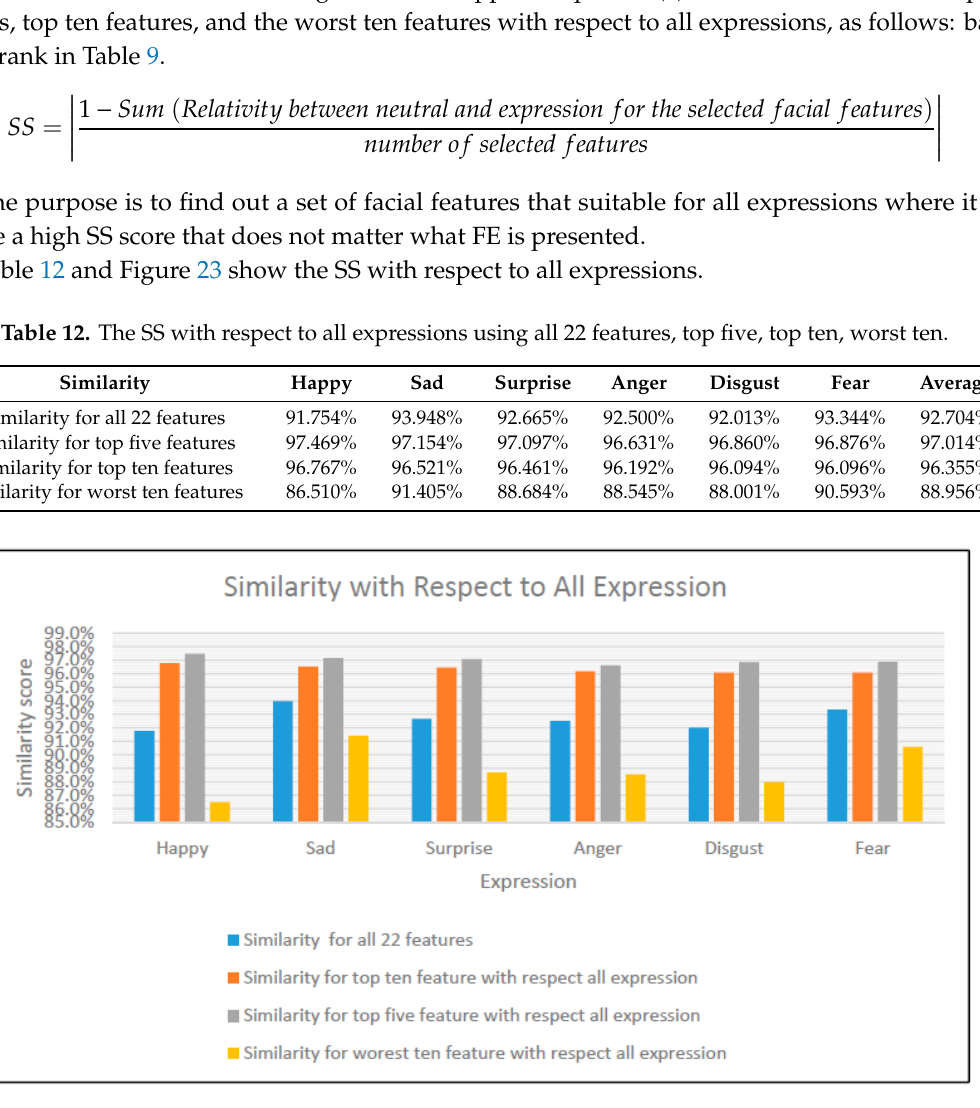
Figure 23. The SS with respect to all expressions using all 22 features, top five, top ten, worst ten. Table 13 and Figures 24–26 show the SS for all 22 facial features, top five, top ten, worst ten with respect to each expression and top five, top ten, worst ten with respect to all expressions. Table 13. SS for all 22 facial features, top ten, top 5, worst ten with respect to each expression and with respect to all expressions.